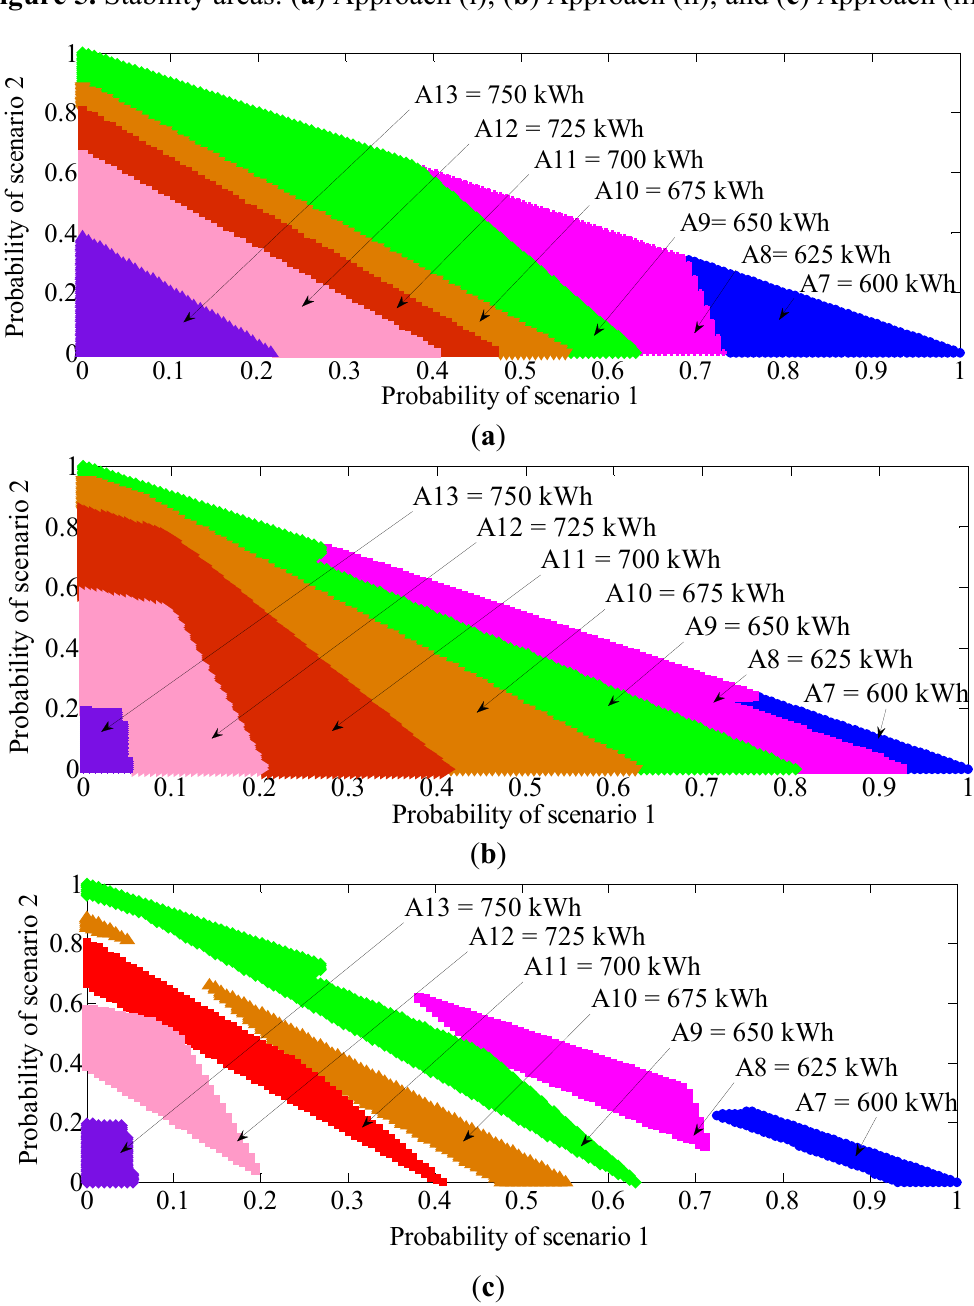
Figure 5. Stability areas: ( a ) Approach (i); ( b ) Approach (ii); and ( c ) Approach